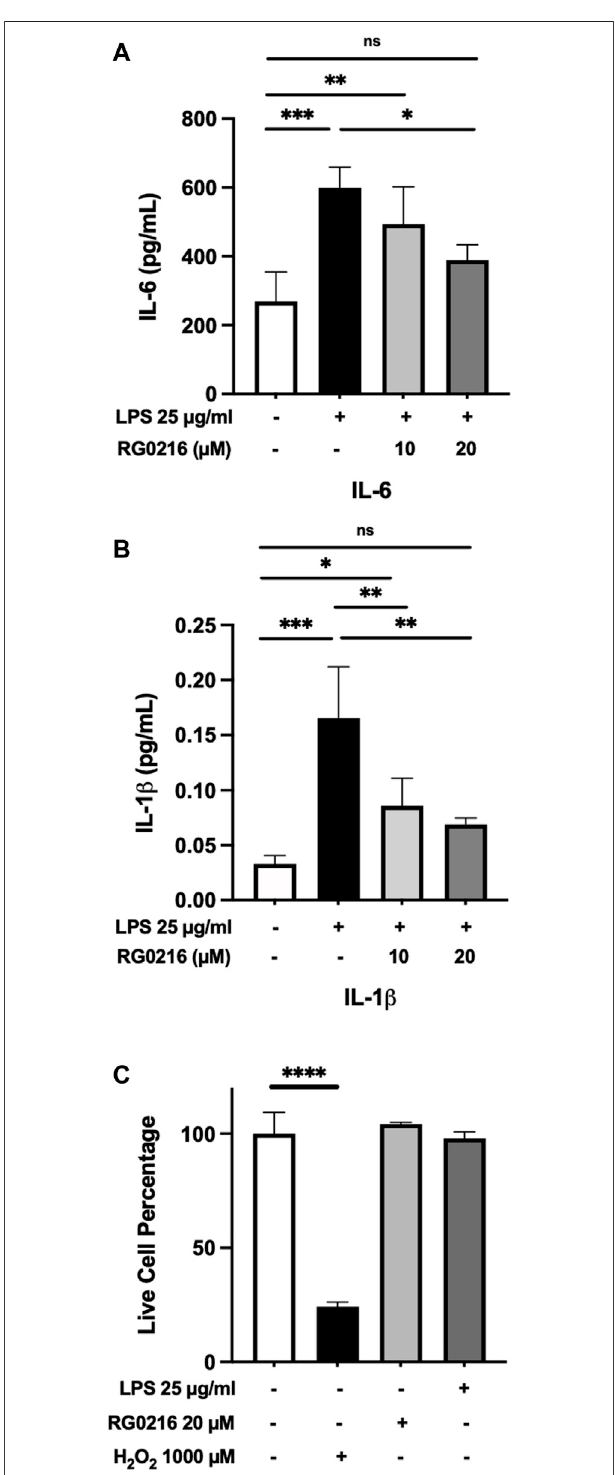
FIGURE 2 | LPS-induced protein expression of IL-6 and IL-1 β in SiHa cellswasreducedinaconcentration-dependentmannerbyRG0216.BothIL- 6 (A) andIL-1 β (B) proteinexpression weresigni fi cantlyincreasedbyLPSand both maximally reduced with 20 μ M of RG0216. (C) RG0216 and LPS